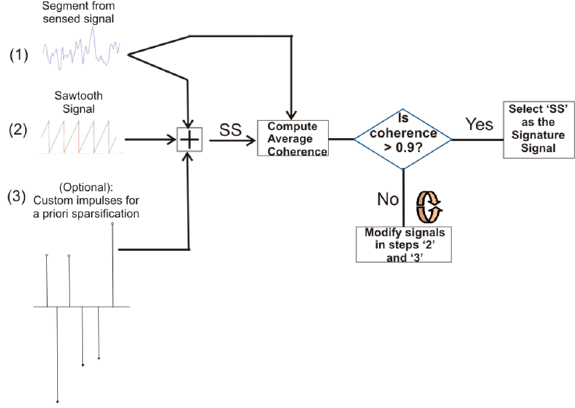
Figure 6. Steps for generating an optimized signature signal.